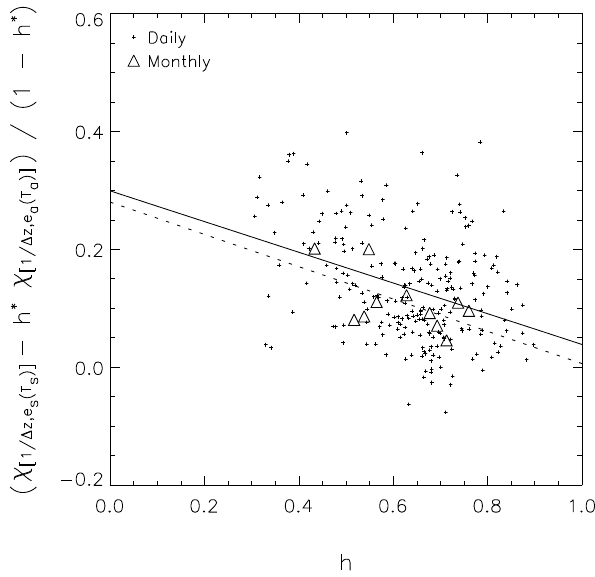
Fig. 7. Relation between the resulting scaling correction (per Eqs. 11 and 12) and the relative humidity for dif- ferent integration periods. (Daily regression (solid line): y = − 0.26 x + 0.30, R 2 =0.13, n =237; monthly regression (dotted line): y = − 0.27 x + 0.28, R 2 =0.34, n =11.) √ 95 % confidence level (= ± 2 × 0.10/ 15). The results